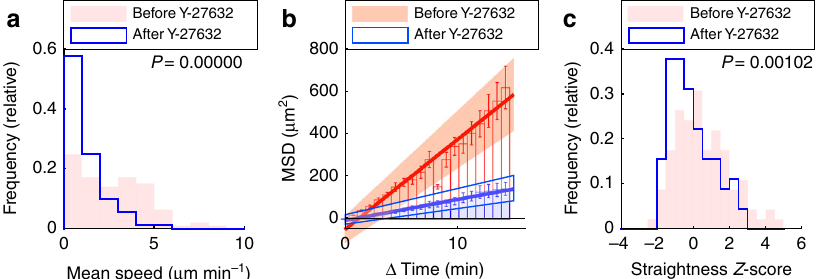
Fig. 7 ROCK is required for straight lung T cell migration. GFP + CD8 + effector T cells were injected i.v. into LPS-treated mice. After two to fi ve days, lungs were explanted and imaged with two-photon microscopy. Identical regions were imaged before and after addition of Y-27632. Tracks with a duration of 15 min were analyzed ( n = 92 tracks both before and after treatment). a – c Mean speed ( a ), time vs. mean squared displacement (MSD) ( b ), and straightness Z -score ( c ) before and after treatment with inhibitor. b Bars show mean squared displacement. Also shown are standard errors ( error bars ), linear regression (line), and con fi dence intervals ( shaded areas ). Shown are pooled data from experiments with three distinct mice ( a , c ) or data from a single representative experiment ( b ). P -values were computed with the Mann – Whitney